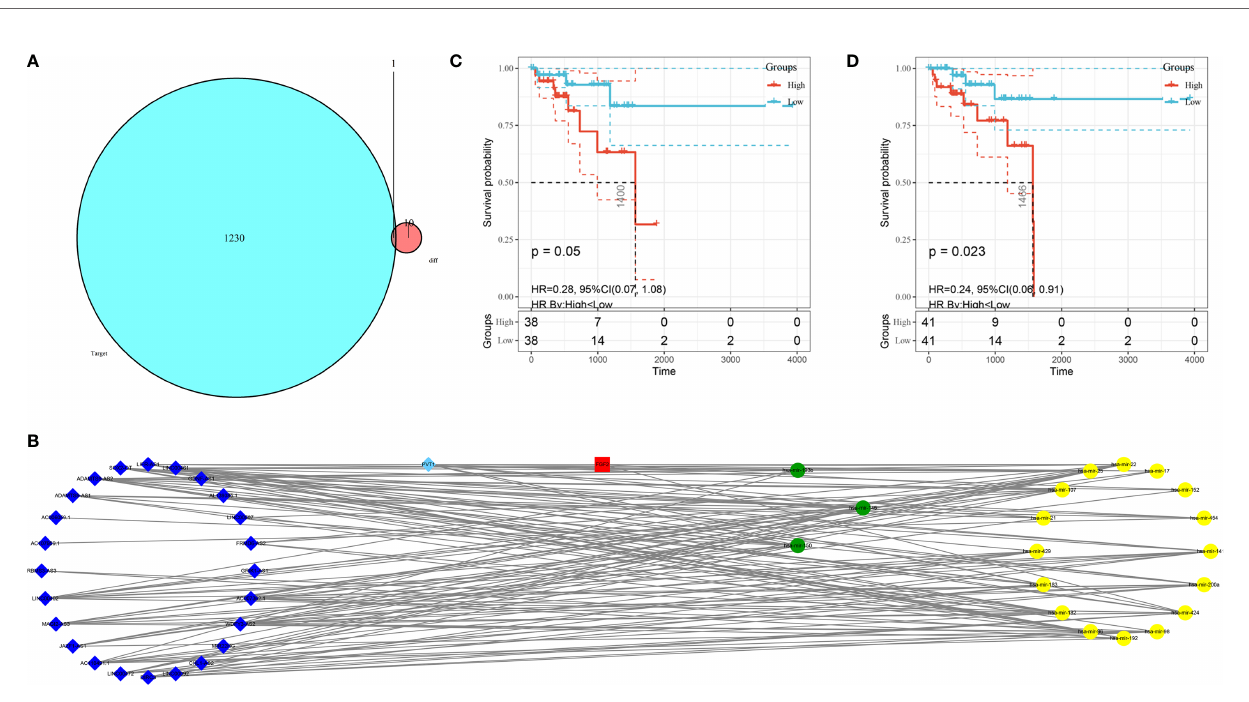
FIGURE 6 | Construction of the ceRNA network and K – M plots of survival. (A) Venn diagram of the identi fi ed candidate mRNA. (B) ceRNA network based on the hub immune-related DEGs. The light blue diamonds show upregulated DElncRNAs; the dark blue diamonds show downregulated DElncRNAs; the yellow circles show upregulated DEmiRNAs; the green circles show downregulated DEmiRNAs; and the red rounded squares show mRNAs. (C) K – M plot of hsa-mir-107. The red line represents high hsa-mir-107 expression group, and the blue line represents the low hsa-mir-107 expression group. (D) K – M plot of WDFY3-AS2. The red line represents high expression of WDFY3-AS2, and the blue line represents low expression of WDFY3-AS2. K – M, Kaplan-Meier.